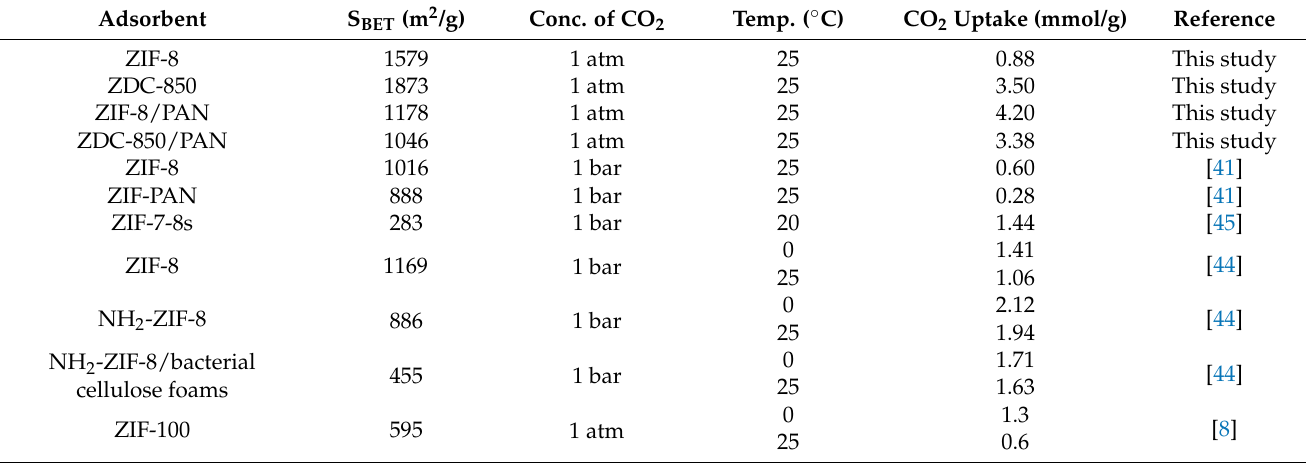
Table 6. Comparison of the CO 2 uptakes of the adsorbents in this study with various ZIF-8-related adsorbents in the